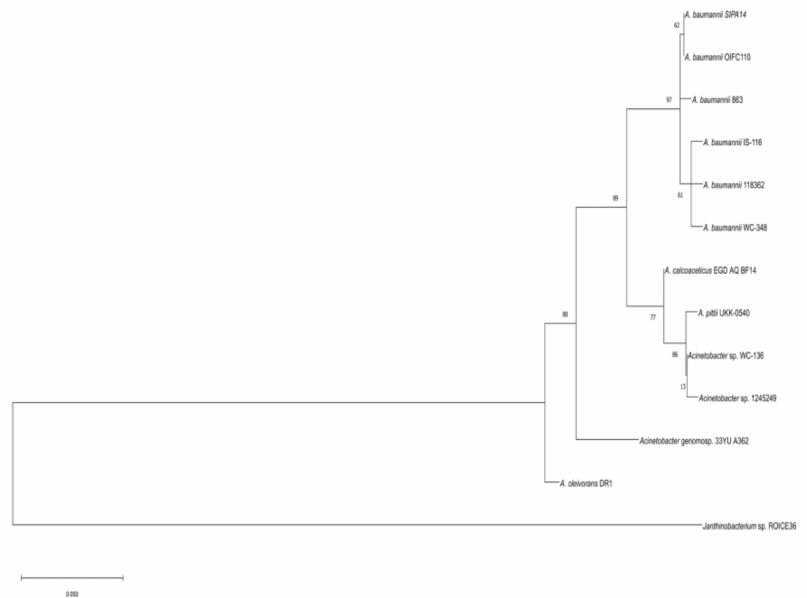
Figure 3. Phylogenetic tree of autoinducer synthase from strain 863 and other Acinetobacter species. The tree was generated using maximum likelihood method based on the Jones-Taylor-Thornton (JTT) matrix-based model. The numbers at the node show the bootstrap values as a percentage of 1000 bootstrap replications. Autoinducer synthase from Janthinobacterium sp. ROICE36 (WP_102124182) was used as the outgroup in this tree. NCBI accession numbers: A. baumannii SIPA14